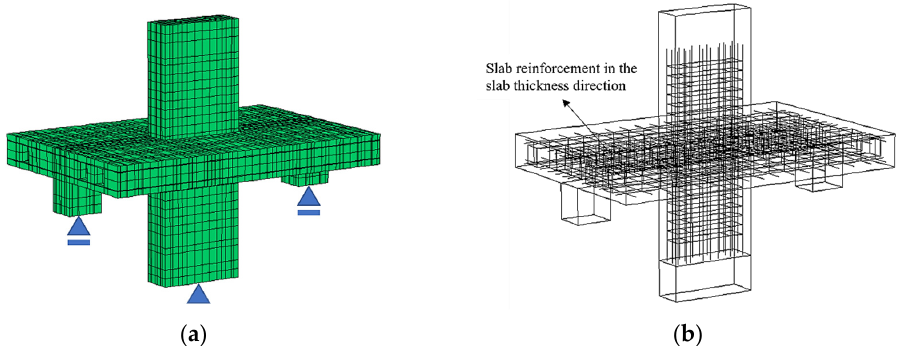
Figure 13. FEM model for Model 1 and 2: ( a ) concrete elements, ( b ) reinforcement elements.